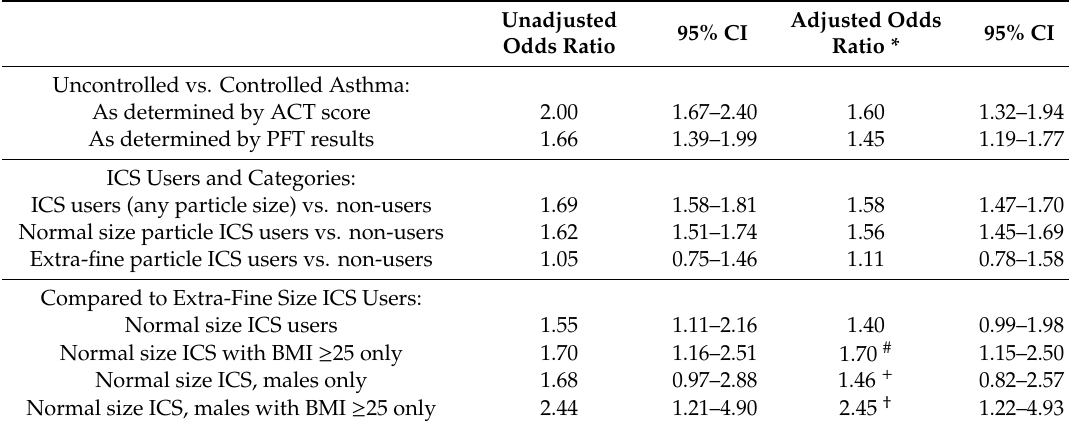
Table 4. Odds for having a diagnosis of